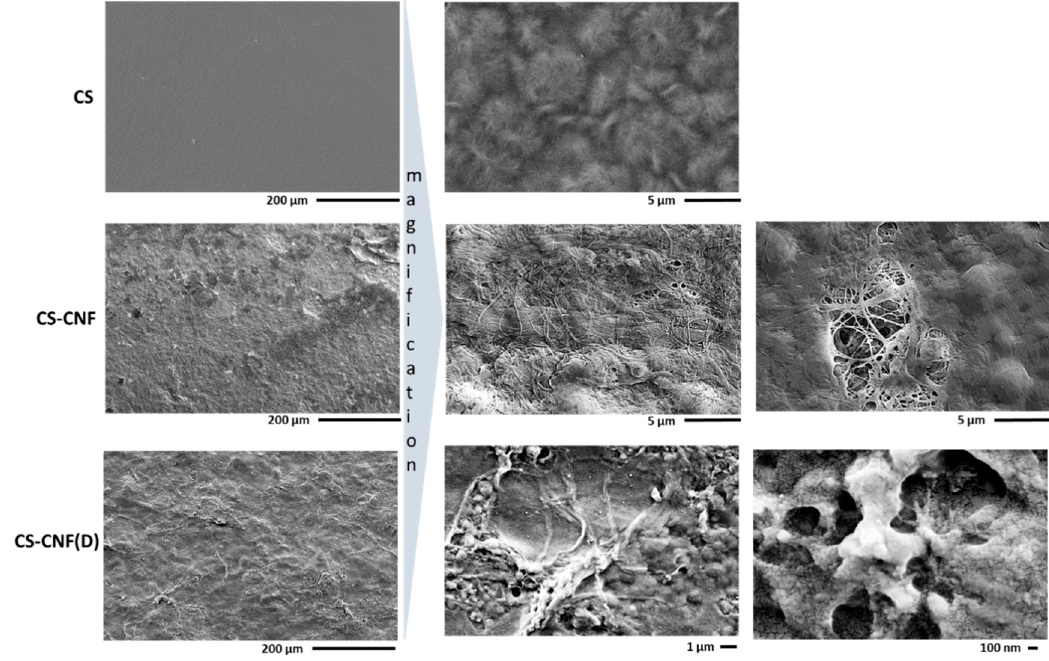
Figure 8. FE-SEM images of CS membranes with CNF and CNF(D) fillers.